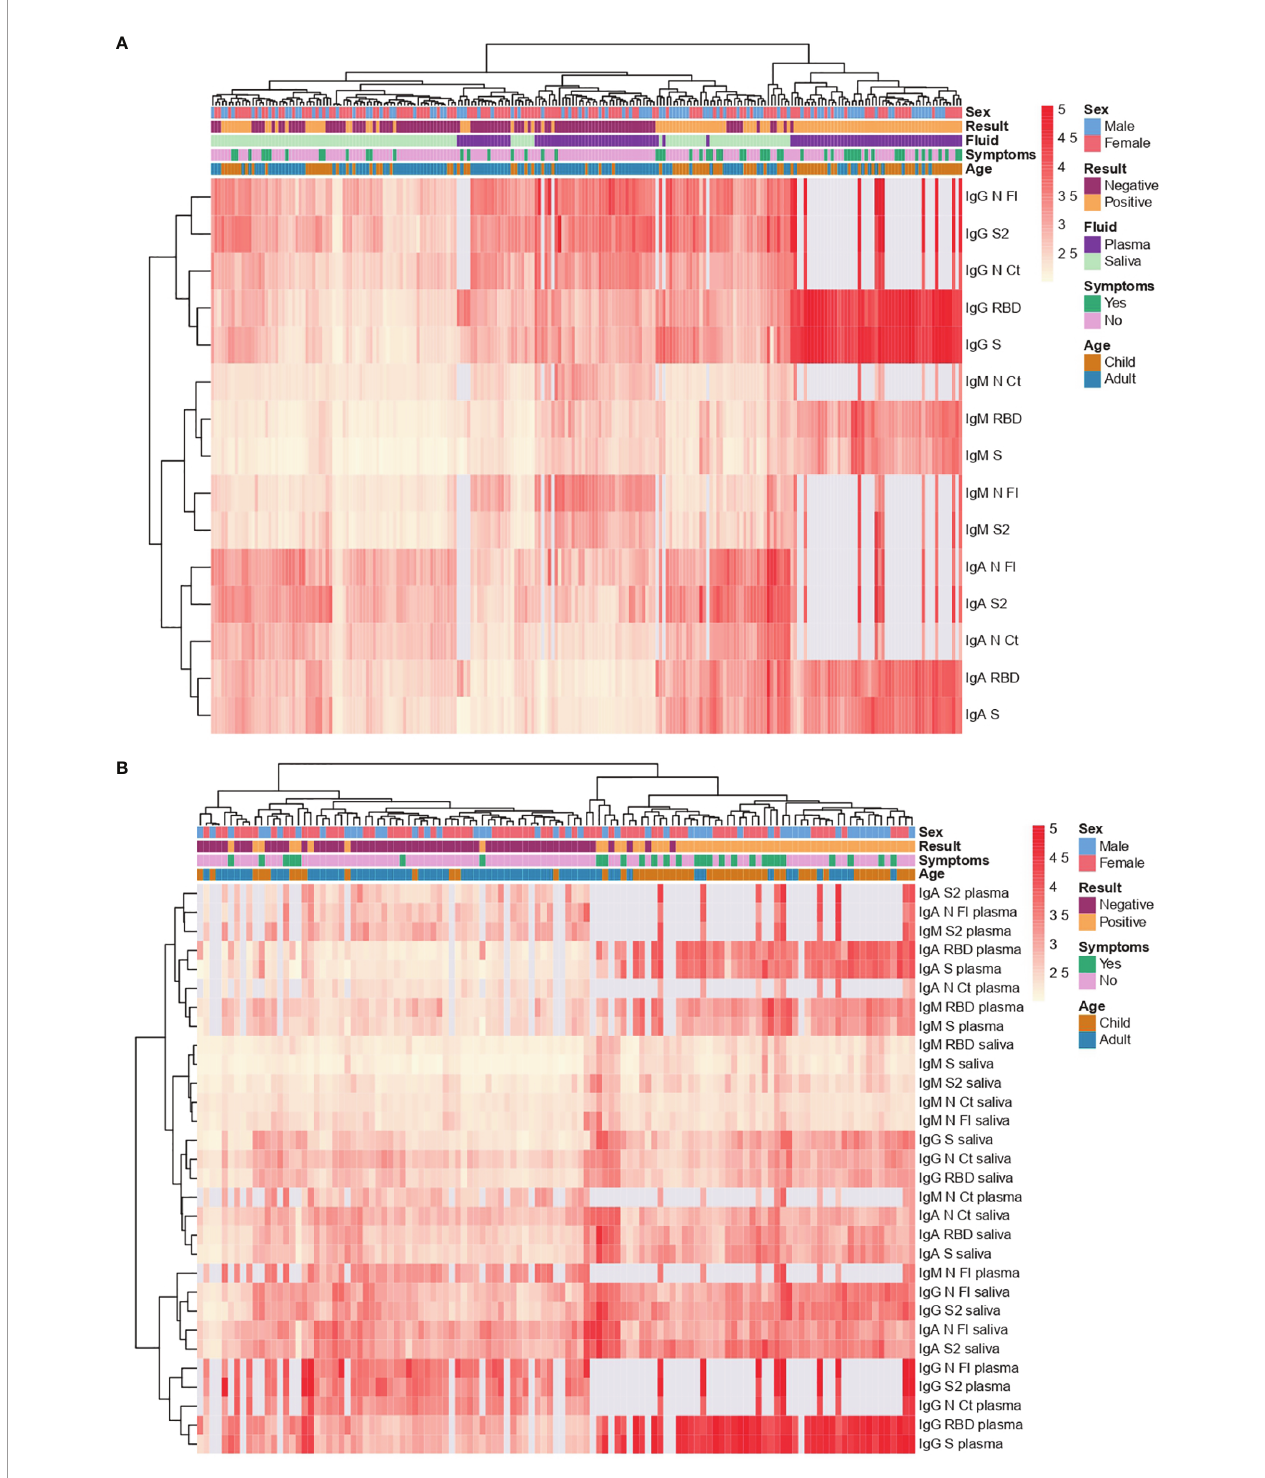
FIGURE 5 | Heatmap with hierarchical clustering. Saliva samples were tested heat inactivated and at 1/10 dilution, and serum (from plasma samples or dry blood spots) at 1/500. (A) Per sample (each column) (B) Per individual (each column). Light grey represents missing data, as more samples were tested for S and RBD than for the rest of